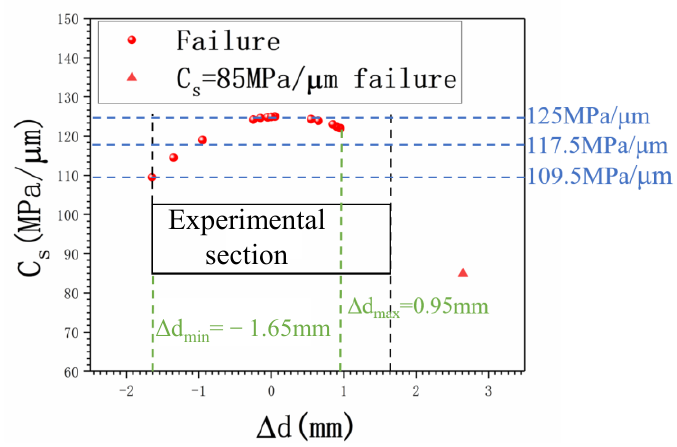
Figure 7. Statistics diagram for the fatigue failure.